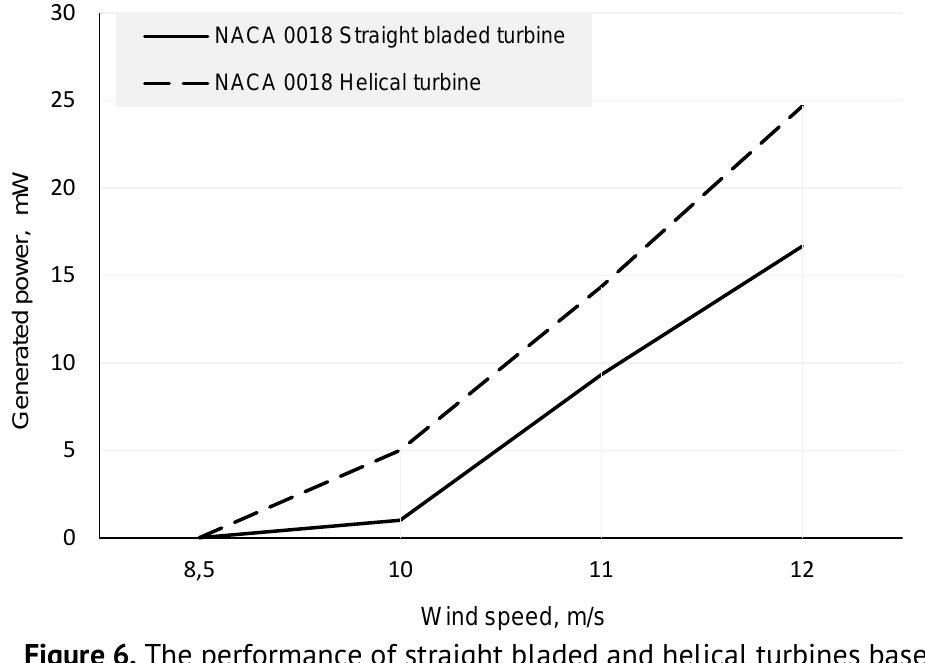
Figure 6. The performance of straight bladed and helical turbines based on NACA 0018 airfoil.